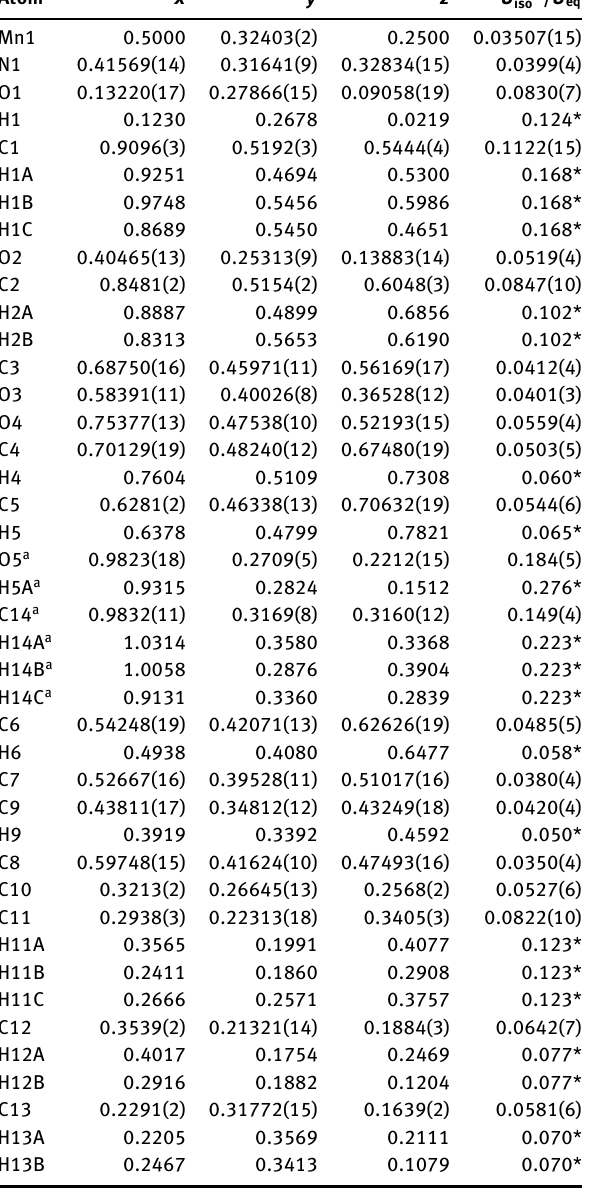
Table 2: Fractional atomic coordinates and isotropic or equivalent isotropic displacement parameters (Å 2